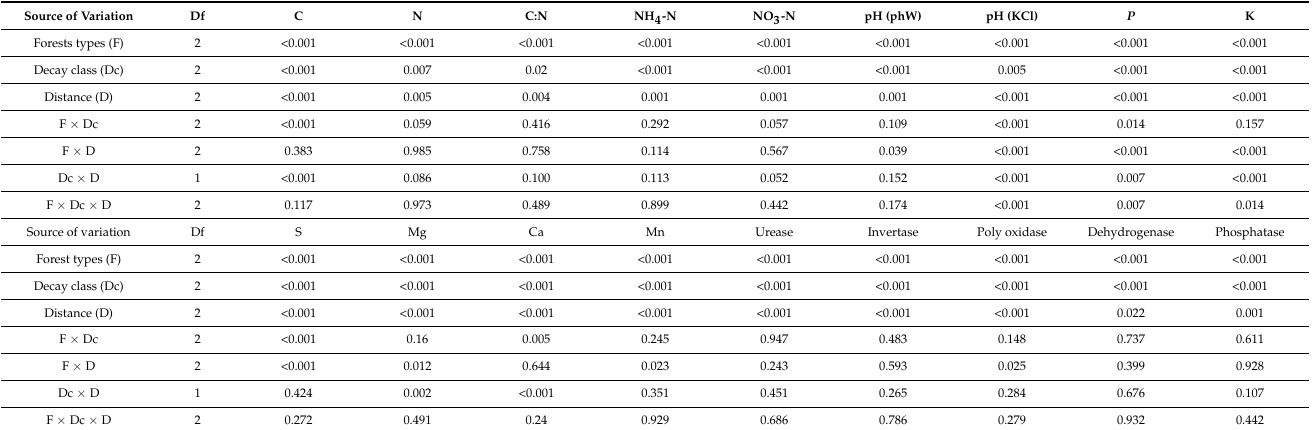
Table 1. Results of an ANOVA on the nutritional contents of distance, decay classes, their interactions and forest types of PAPF, BFF and TPF in Northeastern